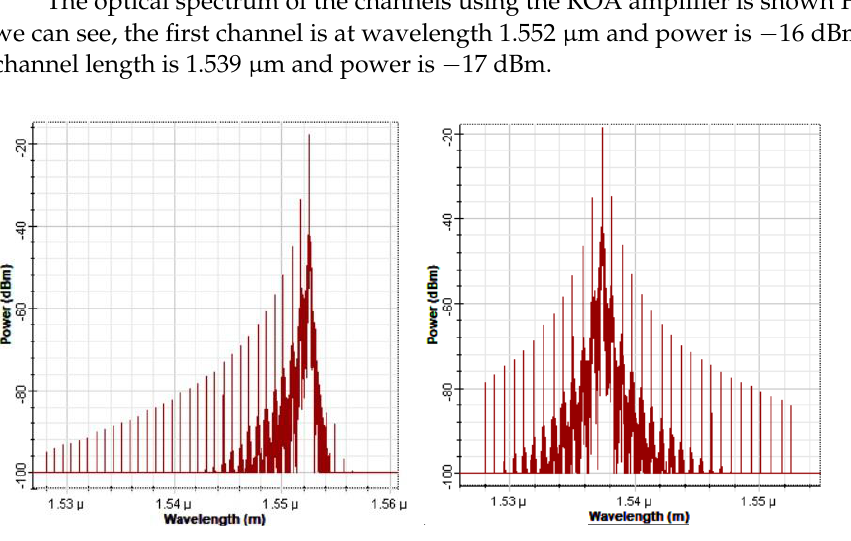
Figure 7. Optical spectrums for the first and twentieth channels ROA.